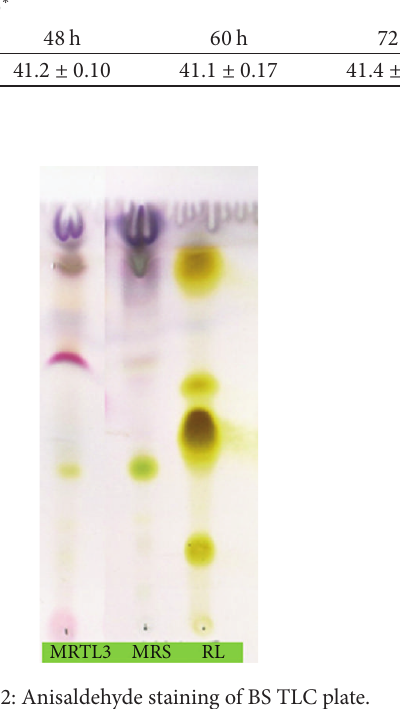
Table 2: Surface tension values (mN/m) of the crude biosurfactant produced by MRTL3. Strain(s)